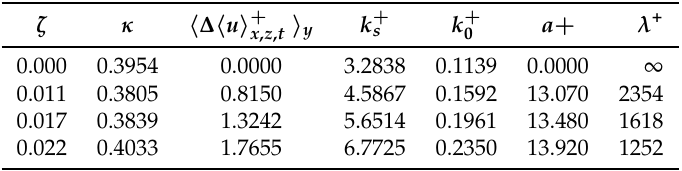
Table 2. Tabulation of estimated turbulence parameters, namely, von Kármán constants for the different cases and commonly used roughness